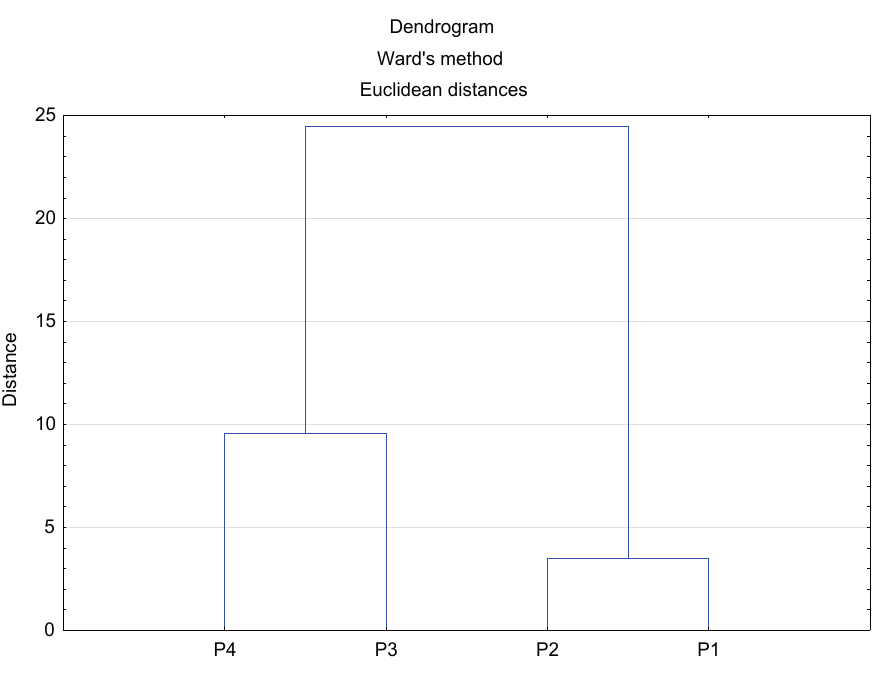
Figure 2. Dendrogram obtained in a cluster analysis for the average PM1 concentration from four sites in the surroundings of working power